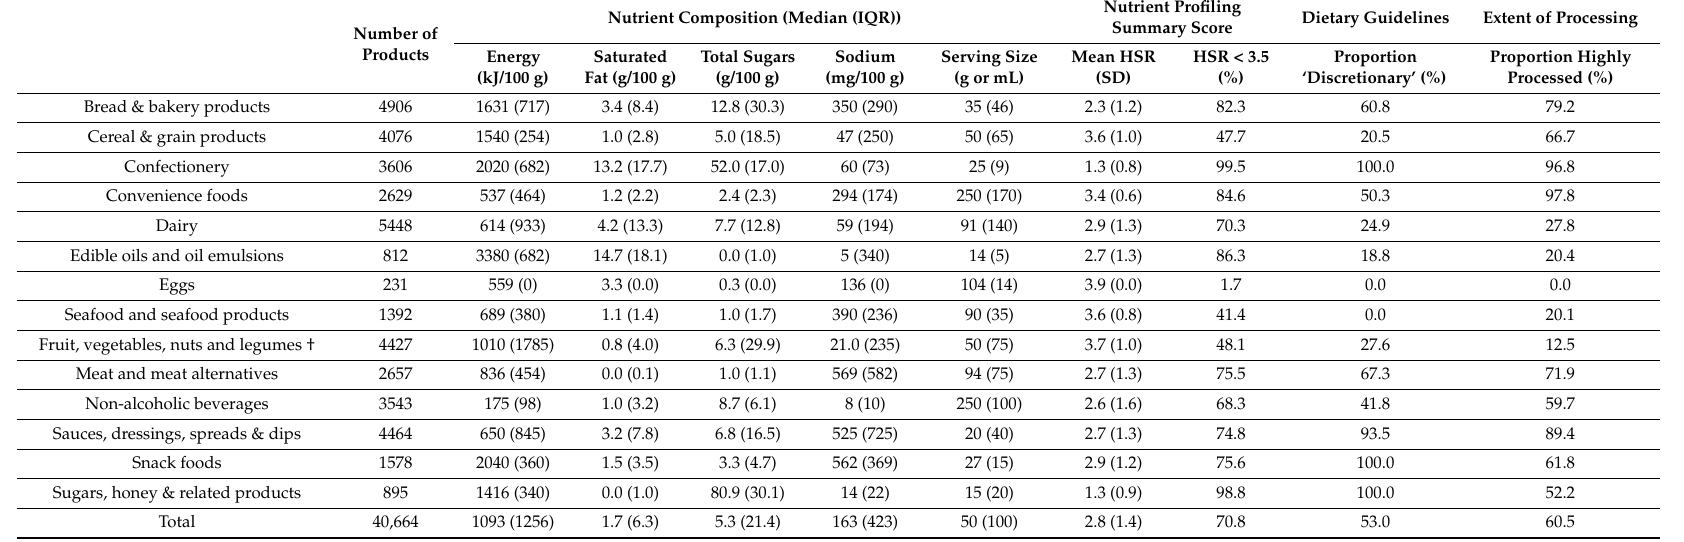
Table 2. Assessment of the nutritional quality of the Australian packaged food supply using multiple measures